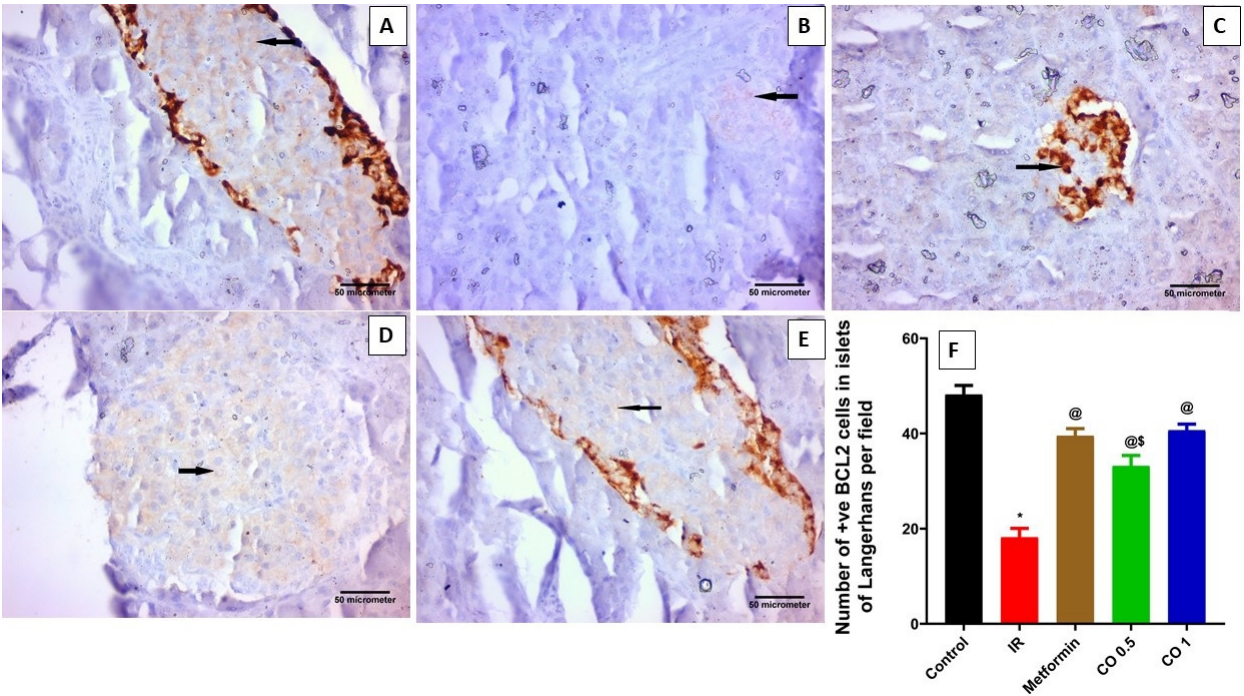
Figure 8. Effect of Effect of coriander oil and metformin on pancreatic anti-apoptotic marker, BCL2 in dexamethasone-induced insulin resistance in rats (RI). Photomicrograph of a pancreatic sections ( A ) control group displaying most of the islet cells are BCL2 positive cells; ( B ) IR group displaying few of the islet cells are BCL2 positive cells; ( C ) metformin group (50 mg/kg/day, PO) displaying many of the islet cells are BCL2 positive cells; ( D ) coriander oil group (low dose, (CO 0.5 mL/kg, PO)) displaying some of the islet cells are BCL2 positive cells; ( E ) coriander oil group (high dose, (CO 1 mL/kg, PO)) displaying many of the islet cells are BCL2 positive cells (Avidine biotin peroxi- dase stain with Hx counter stain X 400, scale bar = 50 μ m); ( F ) Bar graph showing the difference in number of immunopositive BCL2 cells in islets of Langerhans per field in all studied groups that were quantified at ×400. Results were analyzed by one-way ANOVA followed by the post-hoc Tukey test. Results are shown in mean ± SEM (n = 6). * , @, $ p < 0.05 compared to normal, IR, and high dose coriander oil (CO 1) groups, respectively.